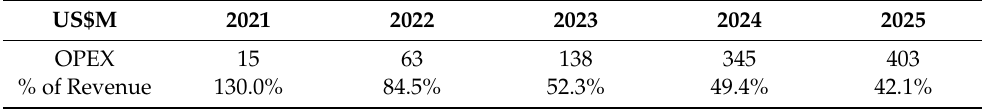
Table 10. OPEX values estimated for the company Li-Cycle. Source: [38]. US$M